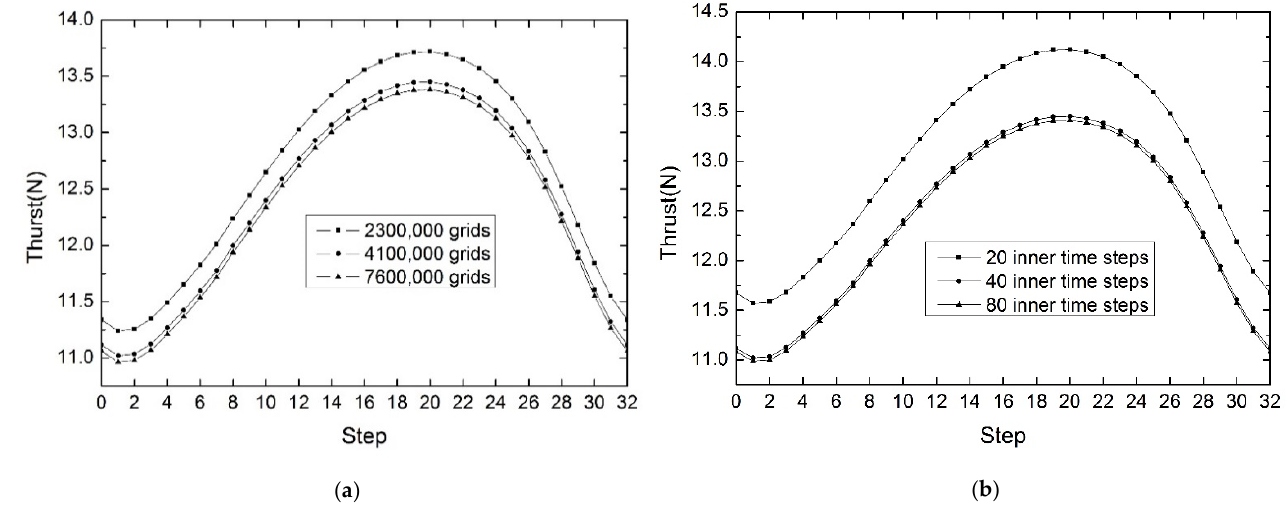
Figure 5. Thrust history of coaxial propellers versus time steps: ( a ) Grid sensitivity test; ( b ) Inner time-step sensitivity test.